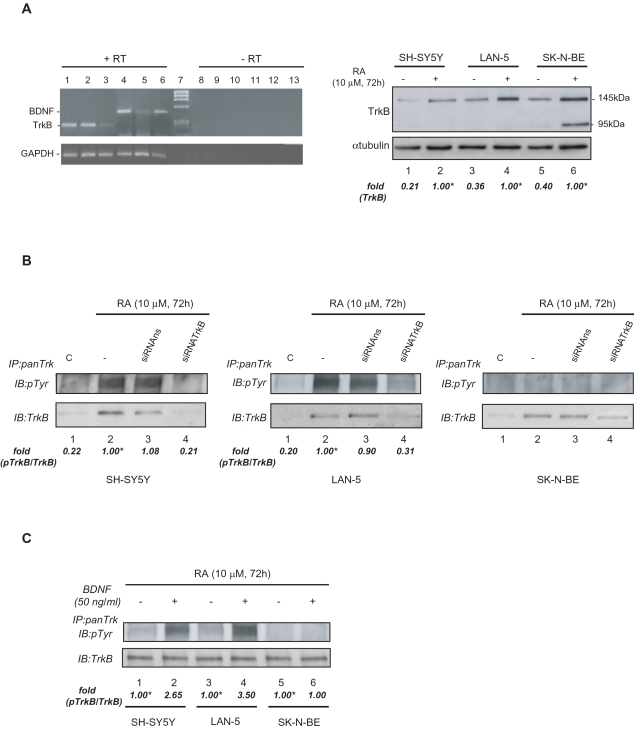
RA-dependent induction of expression and activation of TrkB in NB cells.(A) Left, RNA isolated from RA-treated SH-SY5Y, LAN-5 and SK-N-BE cells was reverse transcribed and amplified as described in Materials and Methods. Samples loaded on the gel are as follows: lanes 1, 2 and 3 amplification of TrkB in SH-SY5Y, LAN-5 and SK-N-BE, respectively; lanes 4, 5 and 6 amplification of BDNF in SH-SY5Y, LAN-5 and SK-N-BE, respectively; lane 7 markers IX (Roche); lanes 8 to 13, RNA samples as in lanes 1 to 6 but in the absence of RT as negative controls. Right, Lysates from SH-SY5Y, LAN-5 and SK-N-BE, left untreated or RA-treated, were immunoblotted with anti-TrkB antibodies against the extracellular domain of the receptor. The molecular weights of full-length TrkB and hypothetical TrkB.T1 isoform are indicated. The membranes were stripped and re-probed with anti-αtubulin? antibodies to control equal loading. Blots shown are representative of at least five independent experiments. (B) SH-SY5Y (left panels), LAN-5 (middle panels) and SK-N-BE (right panels) cells were left untreated or treated with RA in the absence or in the presence of TrkB siRNA (siRNATrkB) or the negative control siRNAns, as indicated. Cell lysates were immunoprecipitated with anti-panTrk antibodies and analysed by Western blotting with anti-pTyr or anti-TrkB antibodies. Blots shown are representative of at least four independent experiments. (C) RA-treated SH-SY5Y, LAN-5 and SK-N-BE cells were left un-stimulated (lanes 1, 3 and 5) or stimulated with BDNF (lanes 2, 4 and 6). Cell extracts were immunoprecipitated with anti-panTrk antibodies and immonoblotted with anti-pTyr or anti-TrkB antibodies. Blots shown are representative of at least three independent experiments. In (A), (B) and (C), quantitation and relative abundances are expressed relative to controls, arbitrarily set to 1 (see legend to Figure 1A).